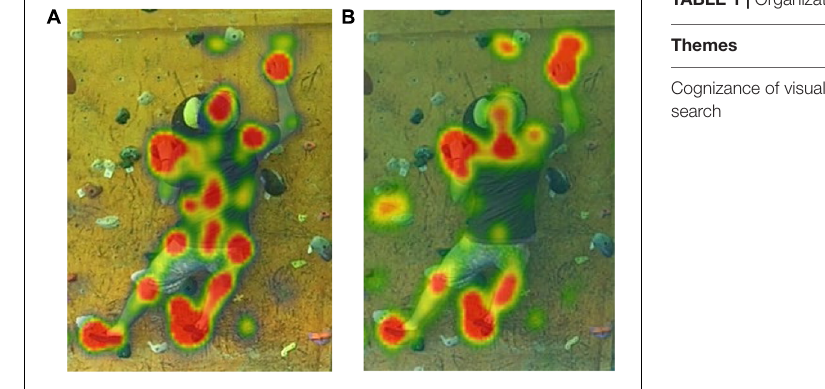
FIGURE 2 | Aggregated heat maps of expert (A) and novice (B) coaches’ gaze behavior over 12 boulder problems illustrate notable differences in the allocation of visual attention to different regions of the climber’s body.